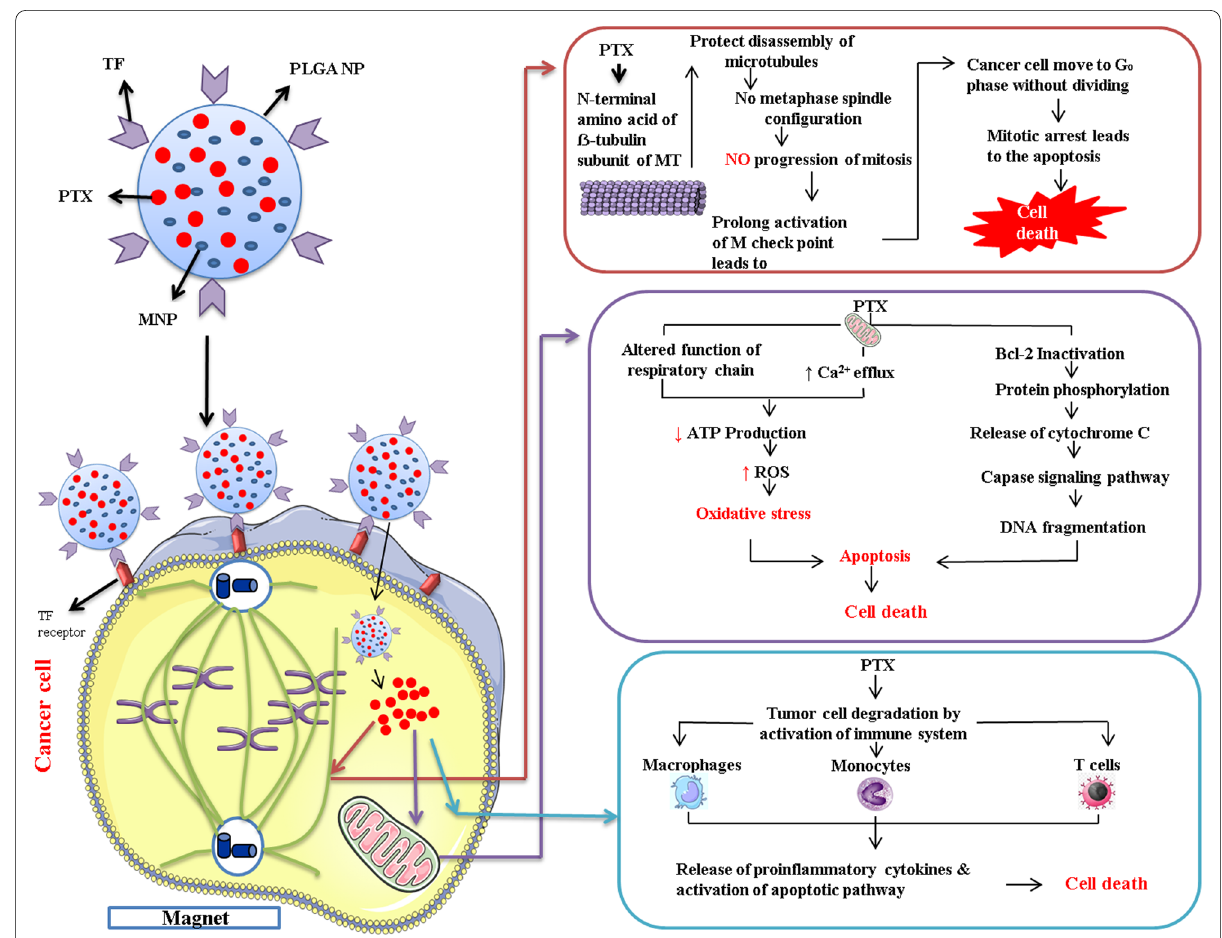
Fig. 3 This figure depicts the expected pathway of magnetic PTX-loaded PLGA-NPs. PTX shows its anti-cancer effect by affecting the microtubules, mitochondria, and immune system.TF: transferrin, PLGA NP: poly (lactic-co-glycolic acid) nanoparticle, MNP: super magnetic nanoparticle,